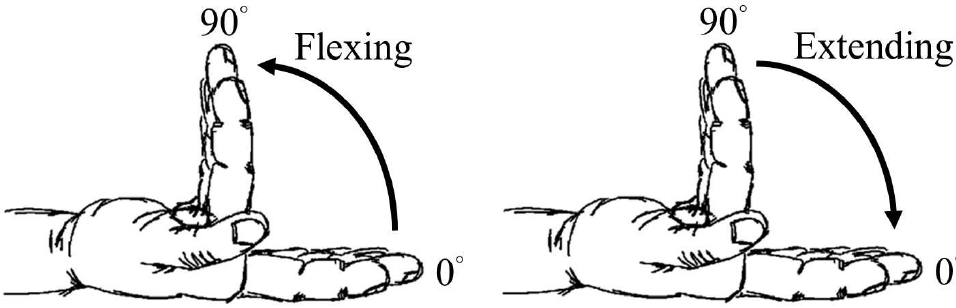
Figure 1. Schematic illustrations of the movements of four fingers during flexion and extension.